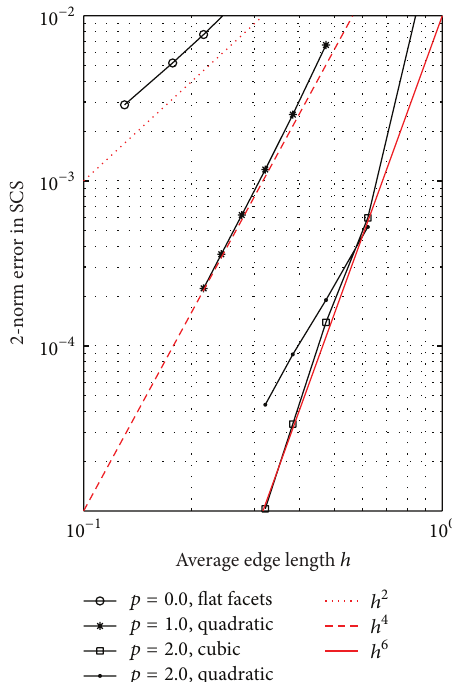
Figure 4: Error in the SCS versus number of unknowns for a sphere with 𝑘𝑎 = 2𝜋 , produced by the EFIE. Results are reported for 𝑝 = 0.5 , 𝑝 = 1.5 , and 𝑝 = 2.5 mixed-order divergence-conforming basis and test functions, in conjunction with cubic-curved-patch